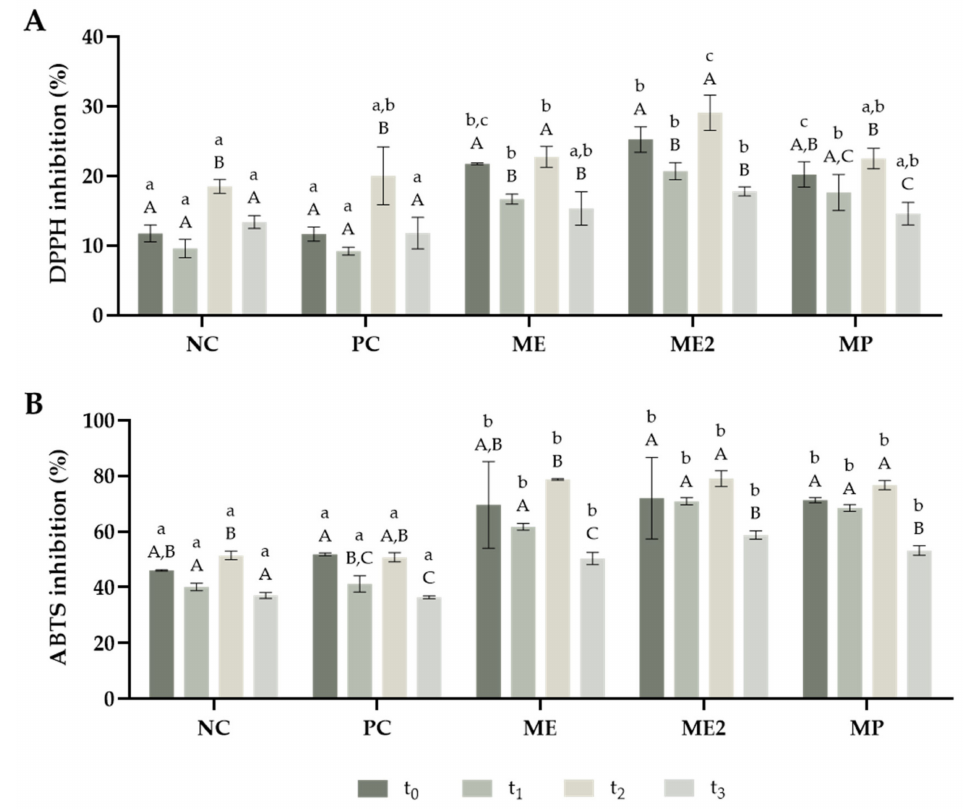
Figure 7. Antioxidant capacity of the yoghurts obtained for DPPH ( A ) and ABTS ( B ) throughout the period of the study. The analysis was performed in different timepoints: t 0 —after production; t 1 — two weeks after production; t 2 —four weeks after production; and t 3 —eight weeks after